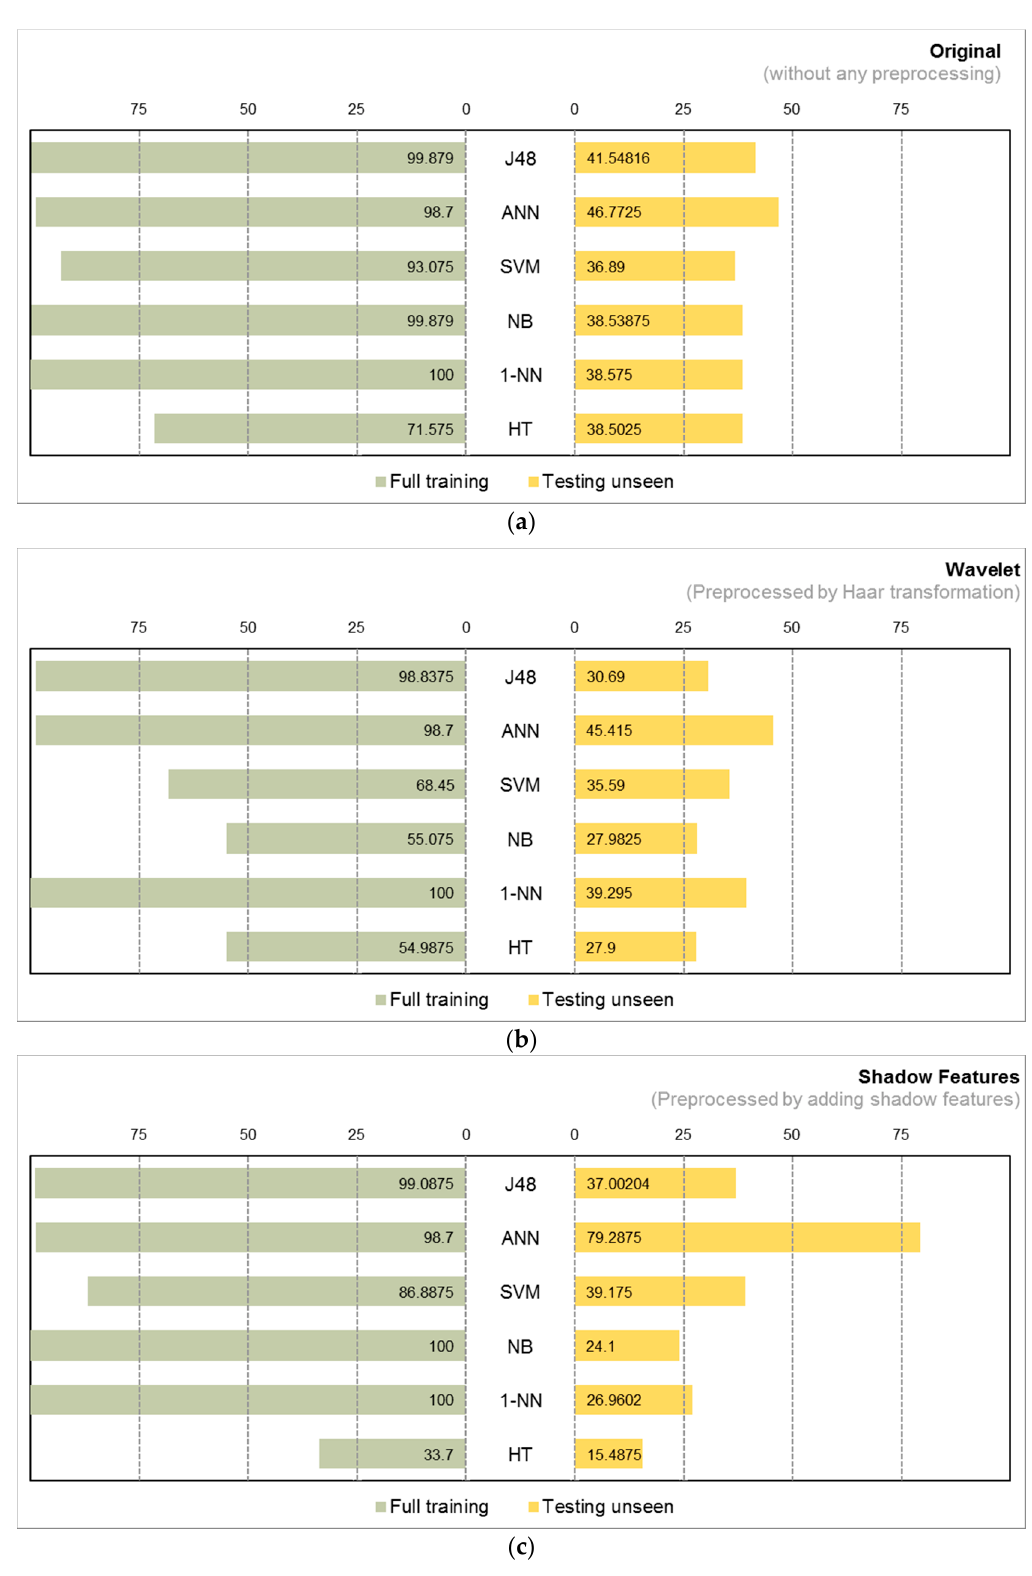
Figure 8. Accuracy of classifiers in accelerometer data with different pre-processing strategies for ( a ) Original; ( b ) Wavelet; and ( c ) Shadow Features.